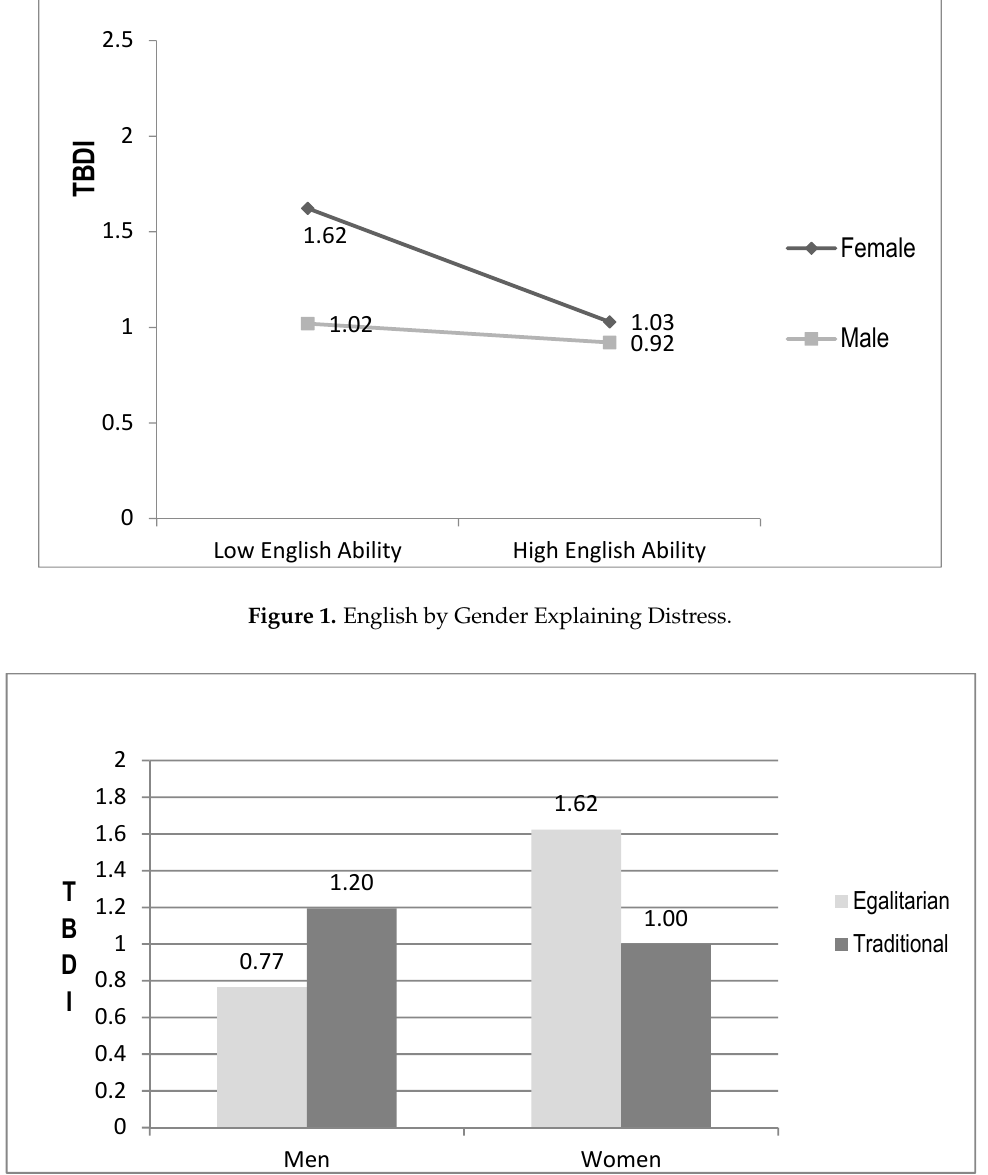
Figure 2. Traditional Gender Ideology by Gender Explaining Distress.